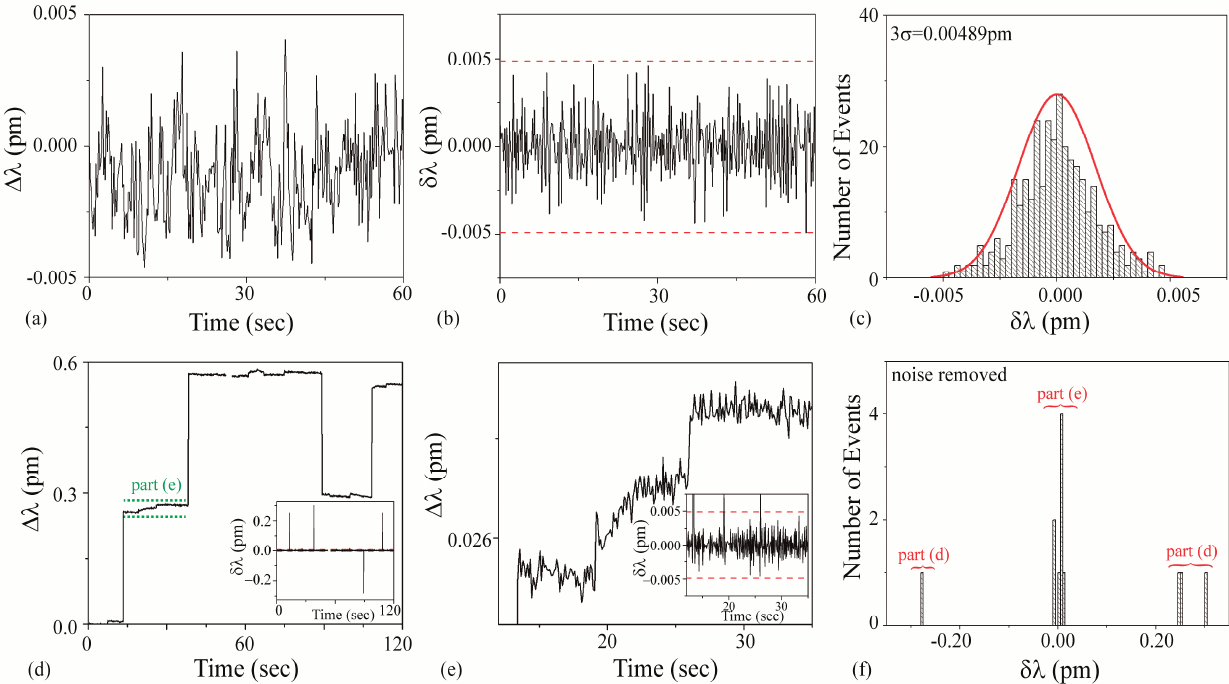
Figure 8. Pig solution: ( a – c ) background and ( d – f ) detection experiments. ( a ) Background wavelength shift ( Δλ ) results; ( b ) background instantaneous wavelength shift ( δλ ) results calculated from part (a) data. The dashed line is the 3 σ noise level determined in part (c); ( c ) Histogram of background δλ results calculated from part (b) data. Based on these results, the 3 σ noise is 0.00489 pm; ( d ) wavelength shift ( Δλ ) upon injection of Pig solution. Inset: Instantaneous wavelength shift ( δλ ) results calculated from this data. The dashed line is the 3 σ noise level determined from the histogram shown in part (c); ( e ) wavelength shift ( Δλ ) upon injection of Pig solution (region indicated in green in part (d)), highlighting small shifts. Inset: Instantaneous wavelength shift ( δλ ) results calculated from this data. The dashed line is the 3 σ noise level determined from the histogram shown in part (c); ( f ) histogram of δλ results shown in part (d). The background noise has been subtracted from the histogram. Both the small and the large shifts are